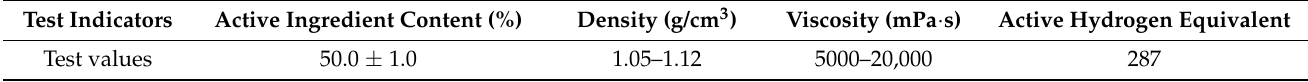
Table 3. Technical properties of the curing agent.